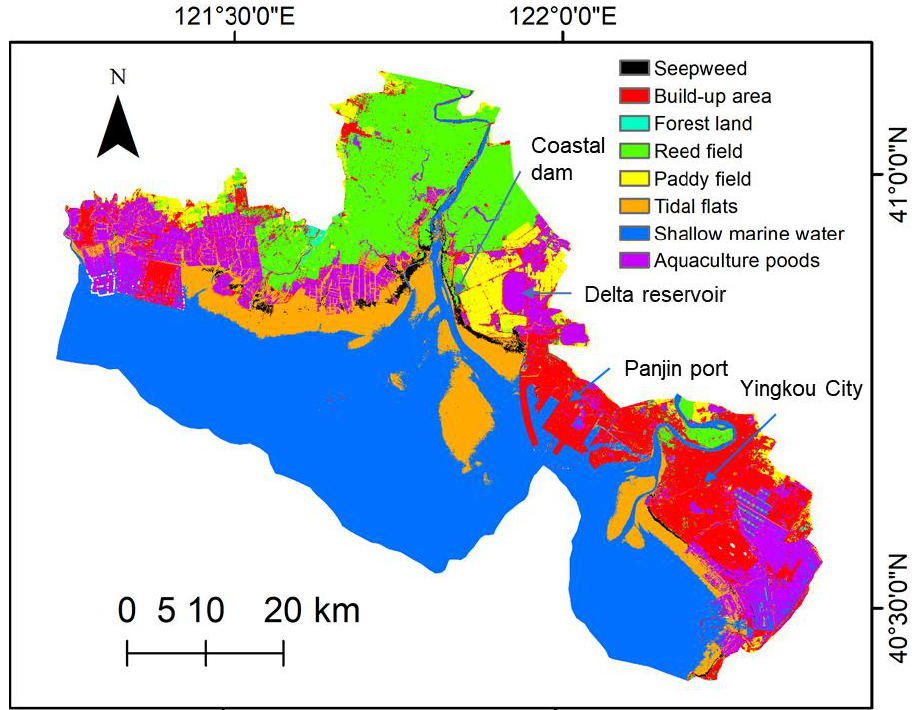
had a very small presence in the region, and its relatively lower PA (0.46) and UA (0.71) had limited impact on the overall accuracy estimate.